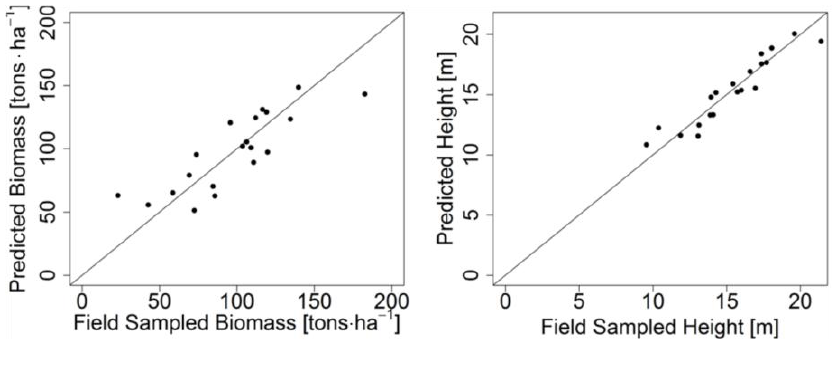
Figure 8. Scatter plots for the 20 flatter stands at Krycklan using field reference data from the BioSAR 2008 campaign, AGB ( Left ) and H ( Right